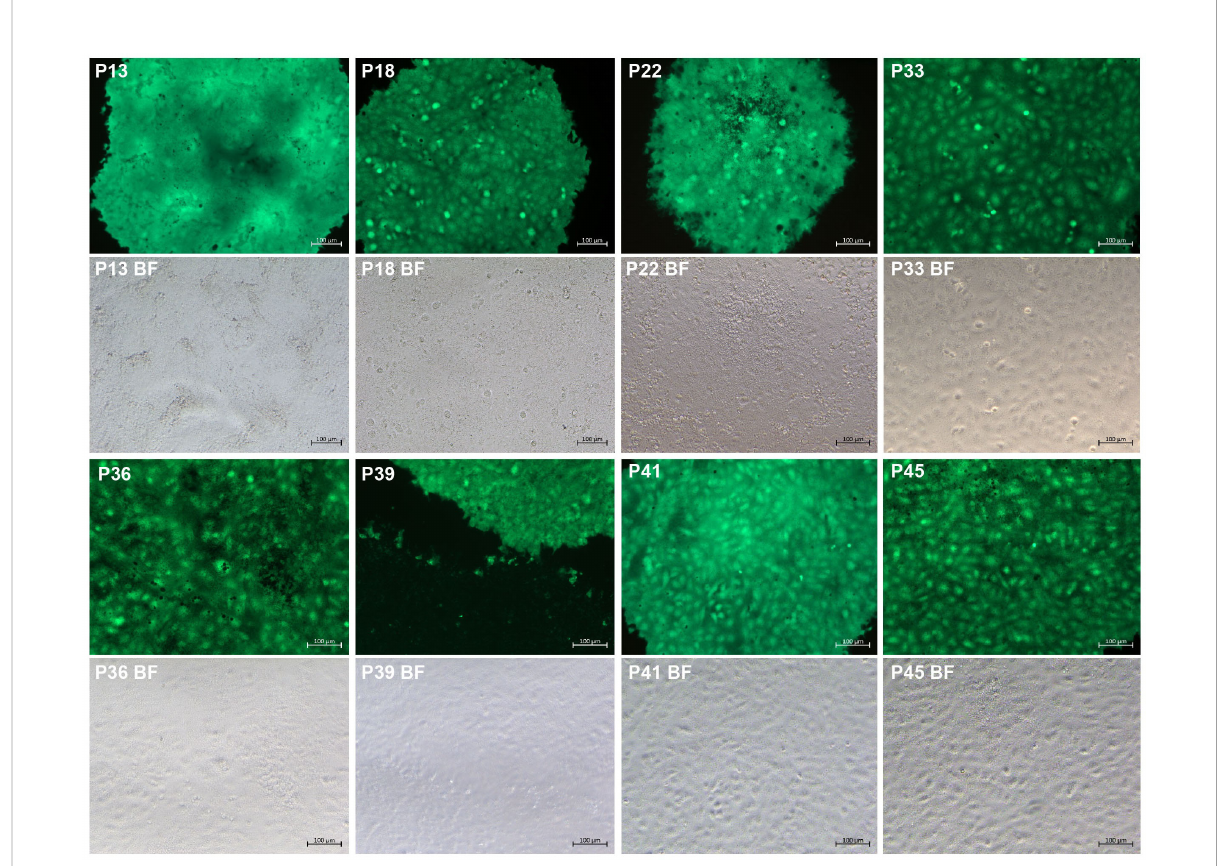
FIGURE 2 Green plaque formation during serial plaque-to-plaque transfers in VDS cell monolayers. BF, bright fi